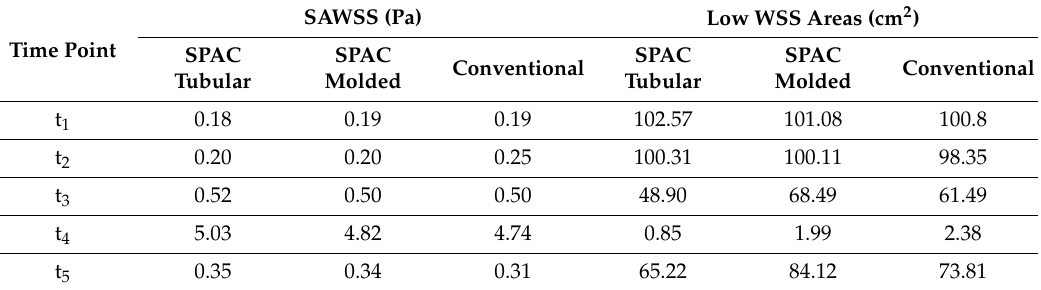
Table 4. The SAWSS magnitudes in different segments of aorta.